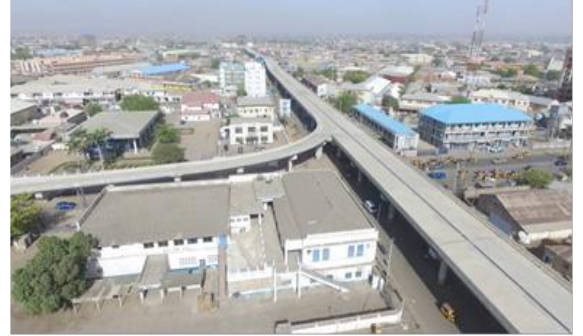
Figure 2: Ariel view of the Murtala Muhammad Way bridge showing a sanitized image that masks the human activity taking place within its vicinity. Source: Salihu T. Yakasai, (2018). In marginal cases, there have been proposals made by authorities towards street vendors.